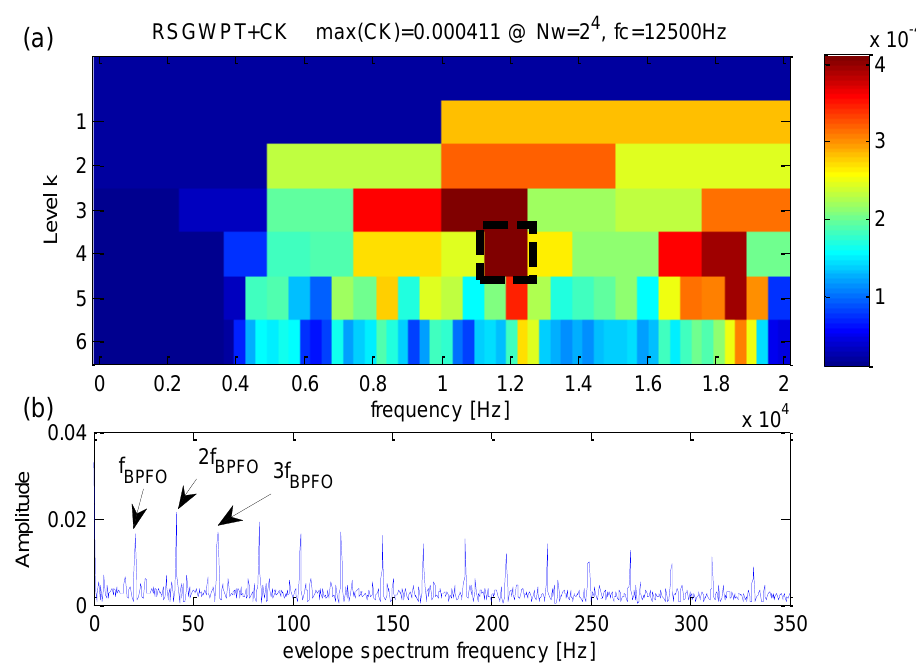
Figure 21. ( a ) The improved kurtogram; ( b ) the envelope spectrum of the frequency band with the maximum correlated kurtosis.